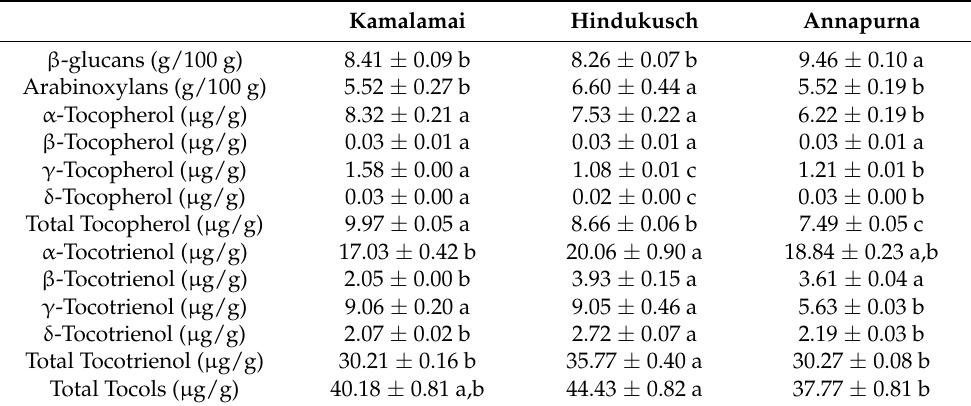
Table 2. β -glucans, arabinoxylans and tocols contents in whole barley